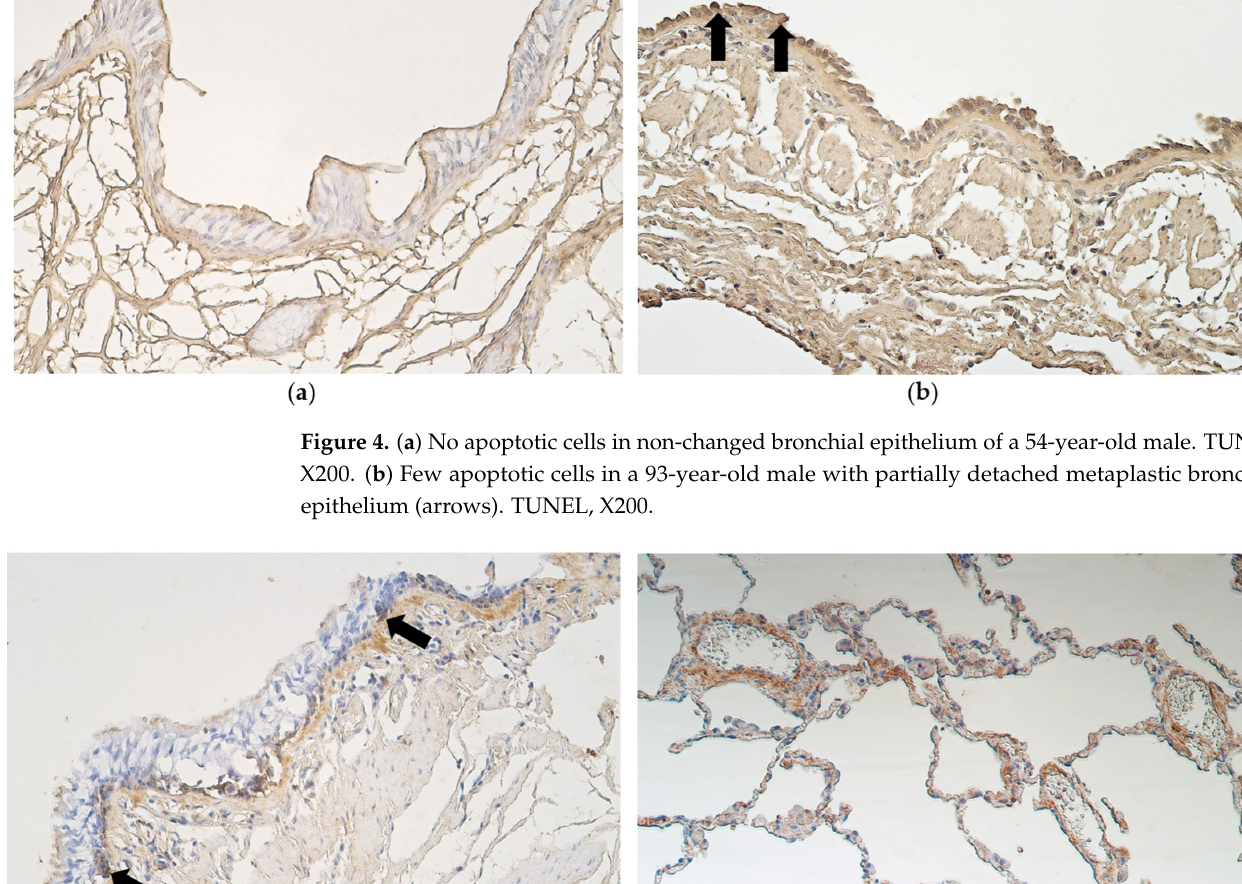
Figure 4. ( a ) No apoptotic cells in non-changed bronchial epithelium of a 54-year-old male. TUNEL, X200. ( b ) Few apoptotic cells in a 93-year-old male with partially detached metaplastic bronchial epithelium (arrows). TUNEL, X200.